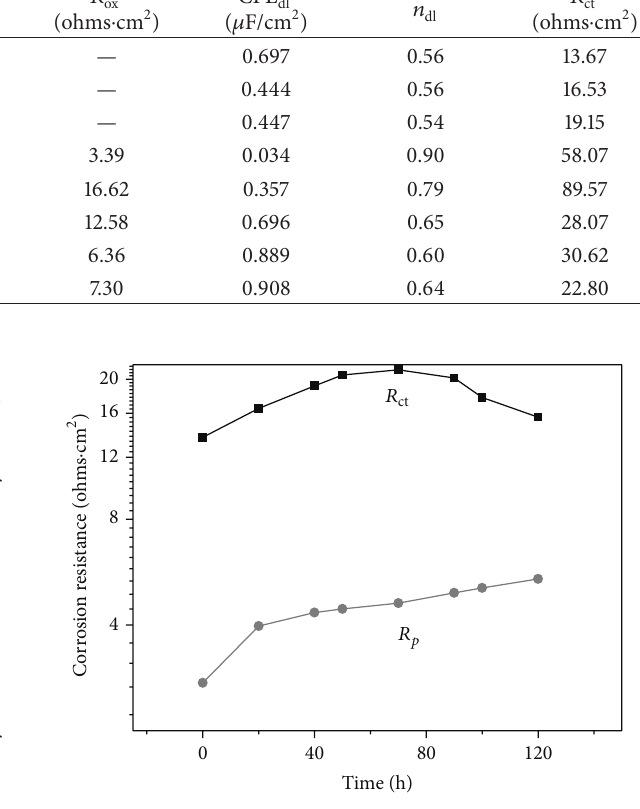
Figure 9: Values of 𝑅 𝑝 and 𝑅